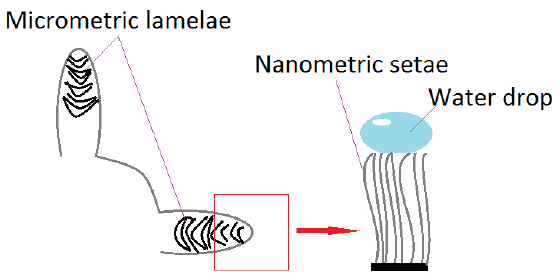
Figure 3. Gecko feet structure. Water drops on setae.